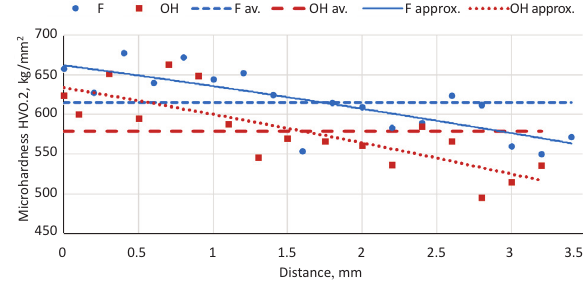
Fig. 7. Horizontal microhardness measurements at α = 36°.